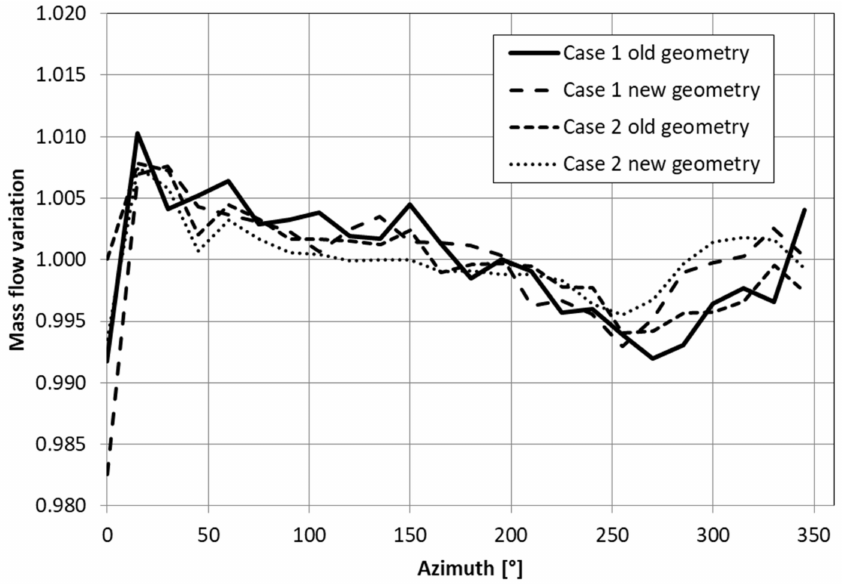
Figure 20. Azimuthal mass flow variation at GV outlet of case 1 and 2 hydraulic